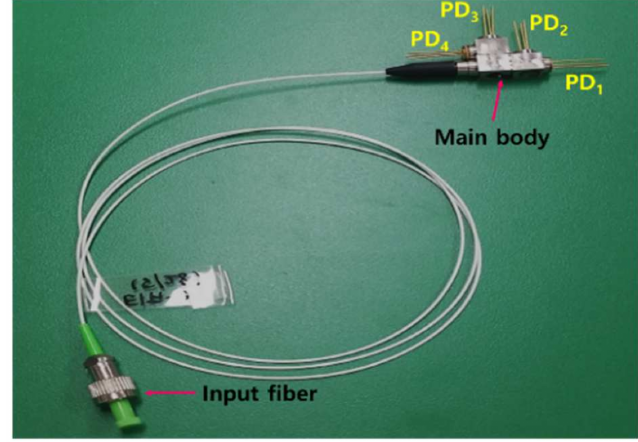
Figure 4. Photograph of a packaged Quad-RX module.